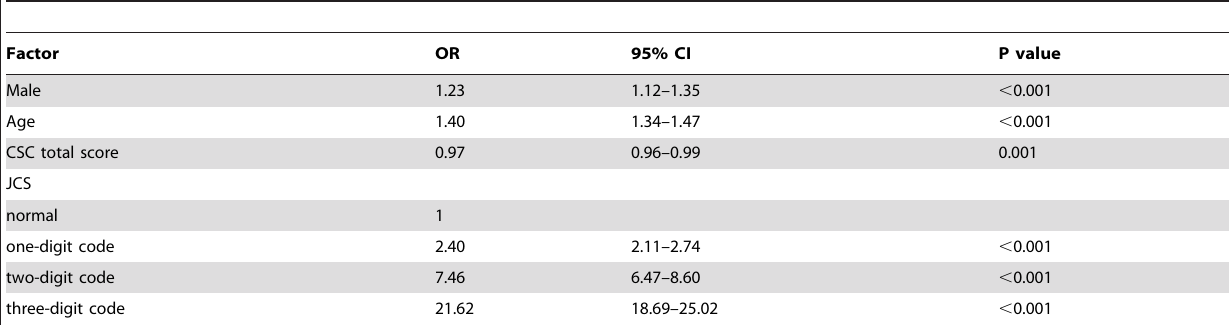
Table 4. The impact of total comprehensive stroke care (CSC) score on in-hospital mortality after ischemic stroke, adjusted by age, sex, and level of consciousness at admission according to the Japan Coma Scale (JCS).